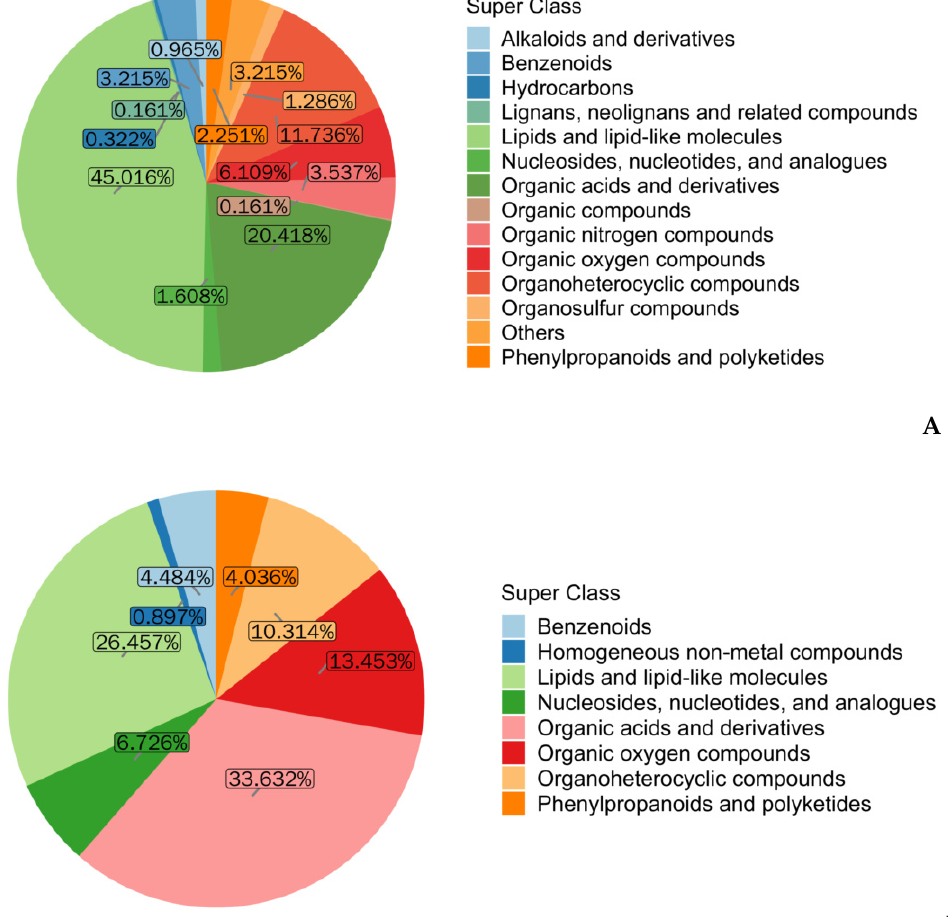
Figure 3. Classification of metabolites identified in boar sperm. ( A ) Major classes of sperm metabolites are identified in the positive ion mode. According to properties of metabolites, sperm metabolites identified in the positive ion mode were classified into different classes. The percentage of each class is shown in the pie chart. The colors represent each class of metabolite. ( B ) Major classes of sperm metabolites are identified in the negative ion mode. Sperm metabolites identified in the negative ion mode were classified into different classes. The percentage of each class is shown in the pie chart. The colors represent each class of metabolite.